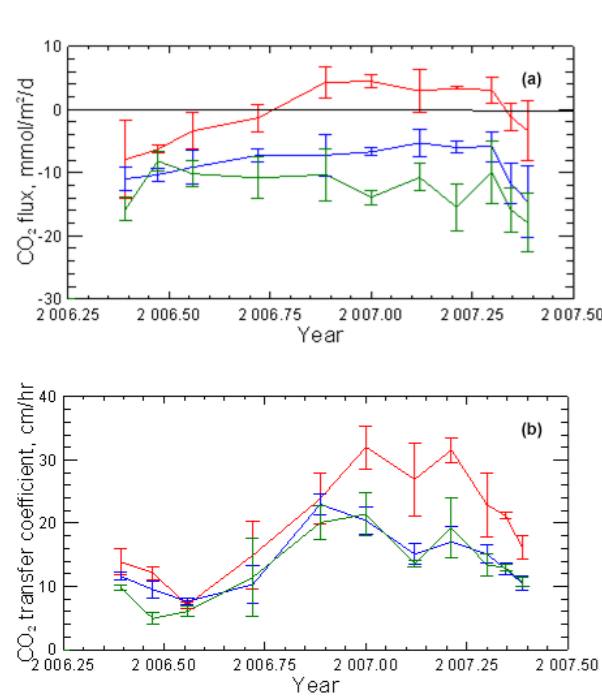
Figure 4. Seasonal air–sea CO 2 flux variations from UW p CO 2 observations. (a) Atlantic Water (red) is a weak sink in summer and neutral over the year, n = 7068. Both Arctic Water (blue) n = 16874 and Polar Water (green) n = 9410 are strong sinks throughout the year. The error bars indicate ± 1 standard deviation from the mean. (b) The gas transfer coefficient for the Atlantic Wa- ter regime is significantly stronger in winter than for the Arctic and Polar Water.